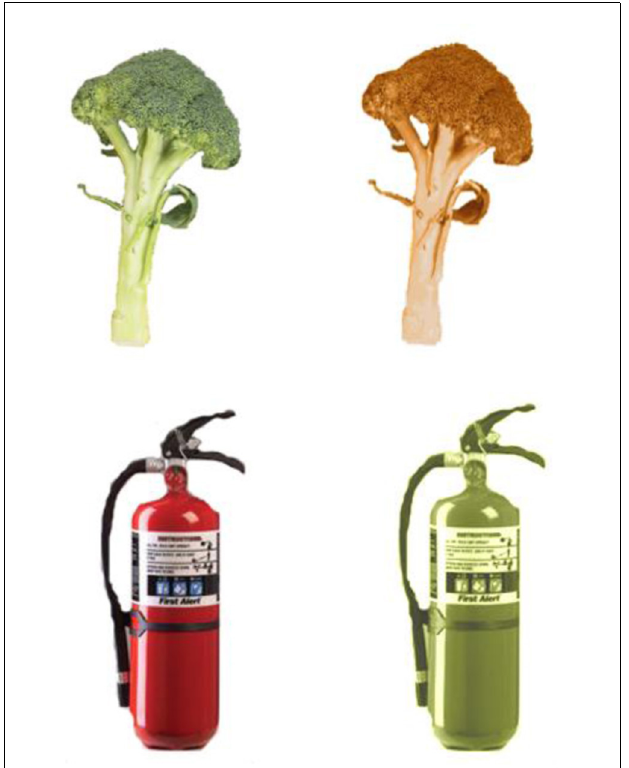
FIGURE 1 | Examples of correctly and incorrectly colored objects presented in the object naming